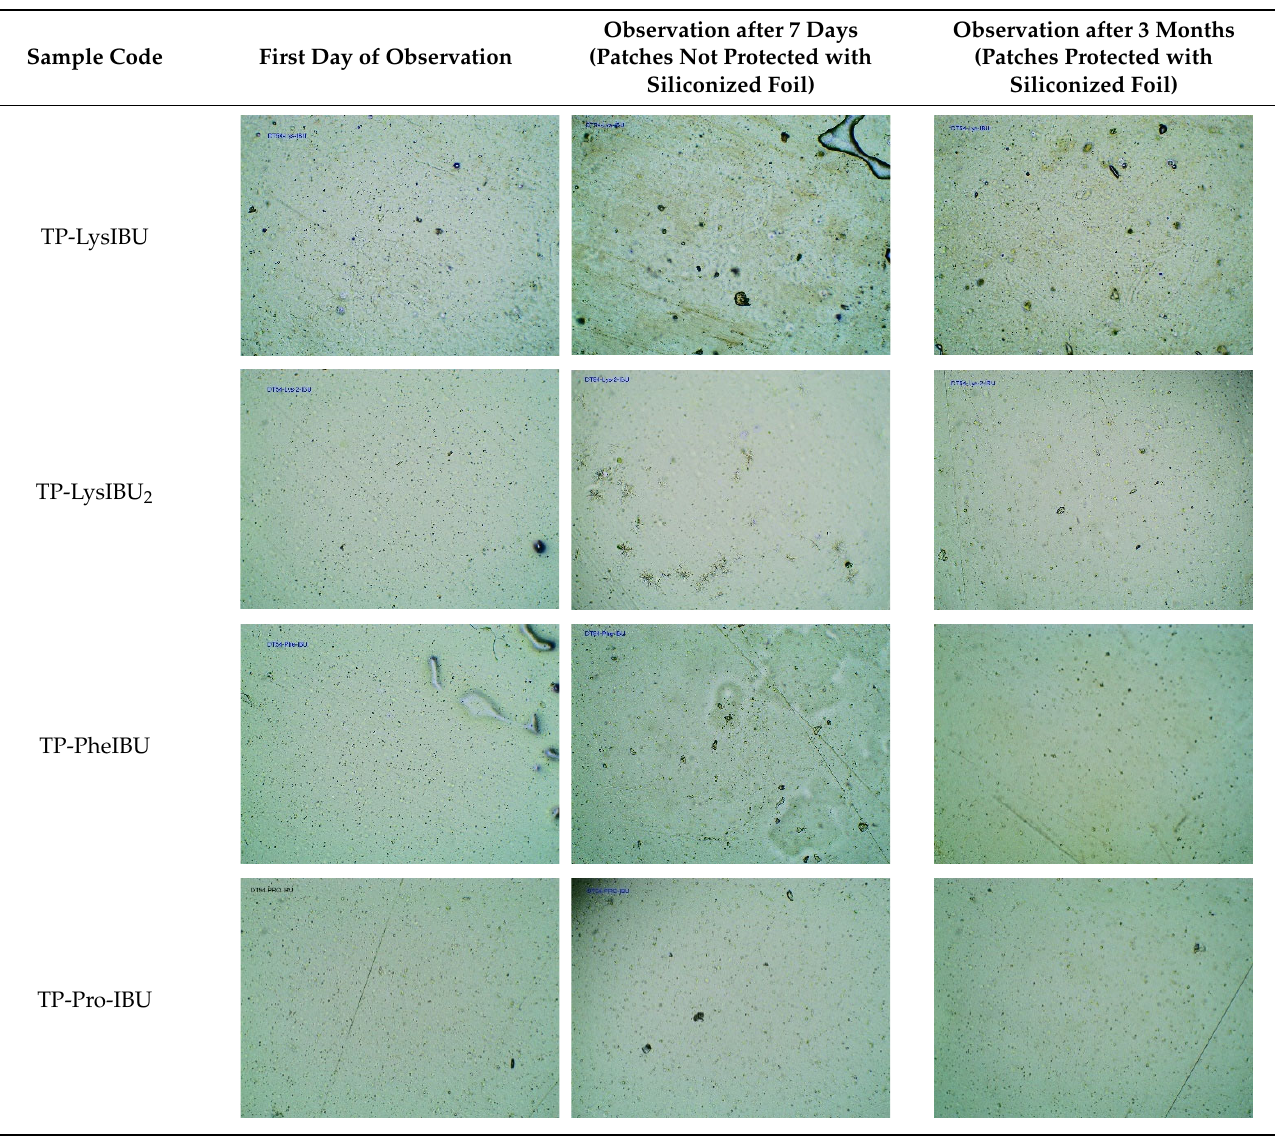
Table 3. The size of drug crystals determined by microscopy.